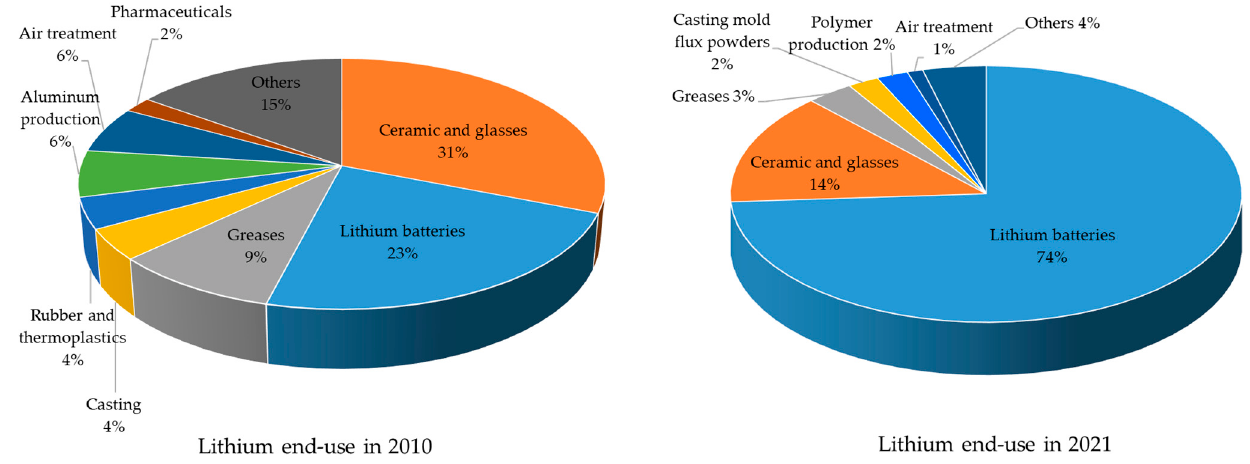
Figure 2. Main applications of lithium.